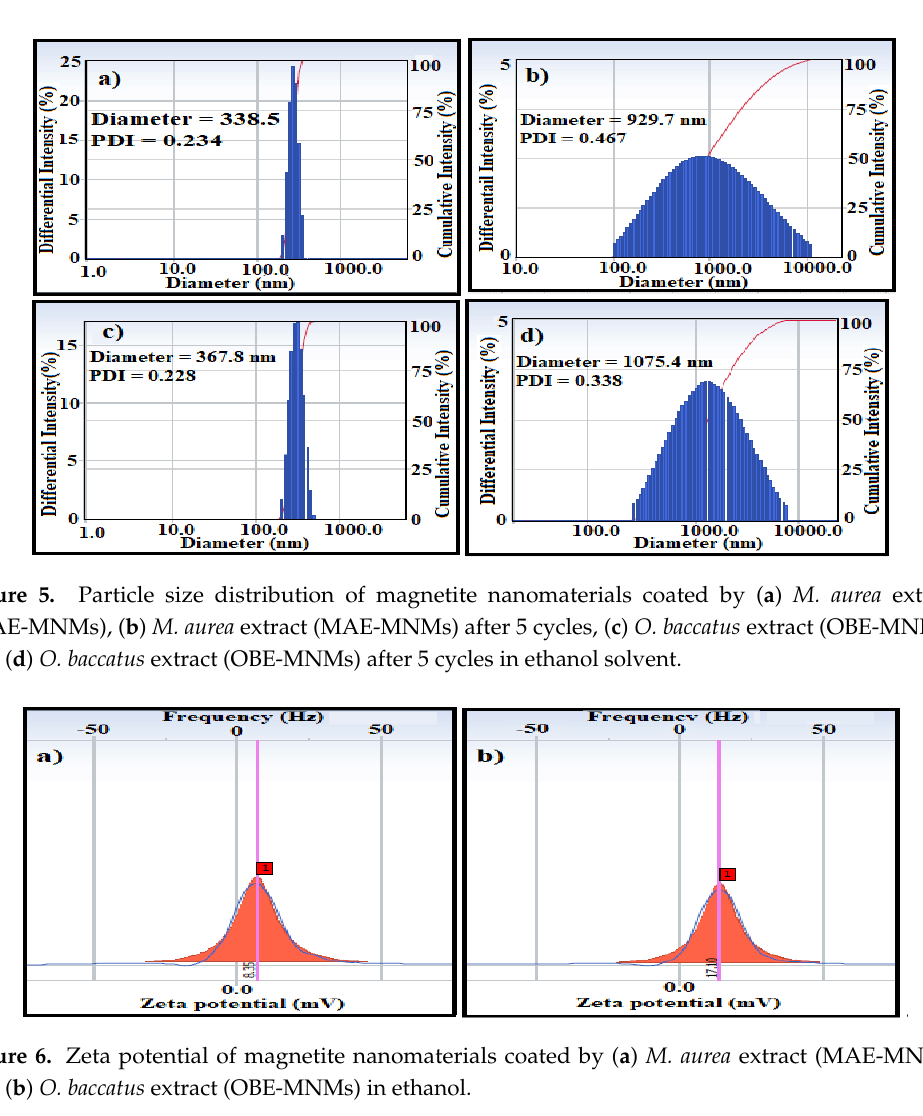
Figure 6. Zeta potential of magnetite nanomaterials coated by ( a ) M. aurea extract (MAE-MNMs) and ( b ) O. baccatus extract (OBE-MNMs) in ethanol.